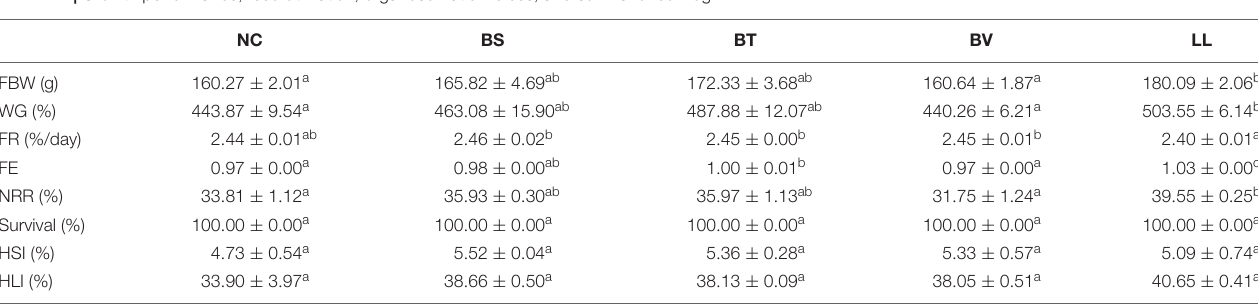
TABLE 2 | Growth performance, feed utilization, organosomatic indices, and survival of bullfrog.